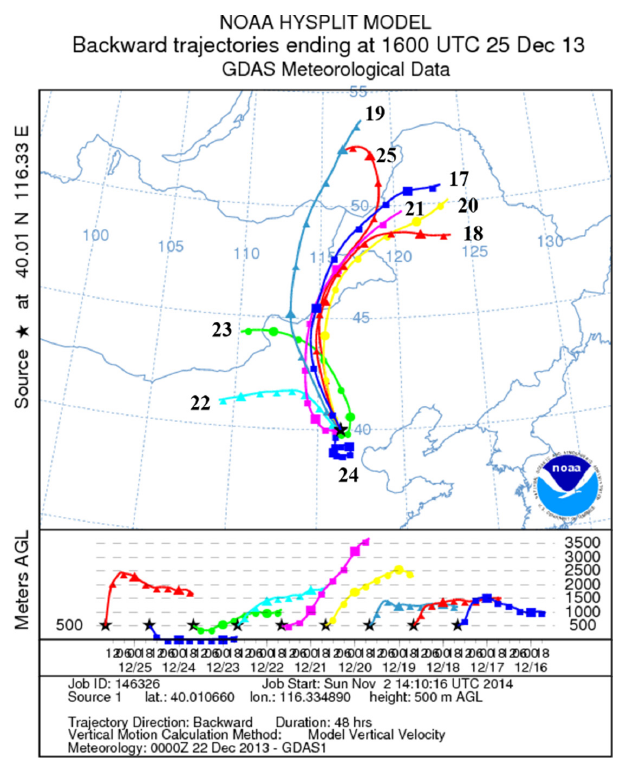
Figure 2. Back trajectories for the sawtooth of 17–25 December 2013. Numbers denote date of arrival of the air at Beijing. Calculations begin at 500 m above ground and continue for 48 h.